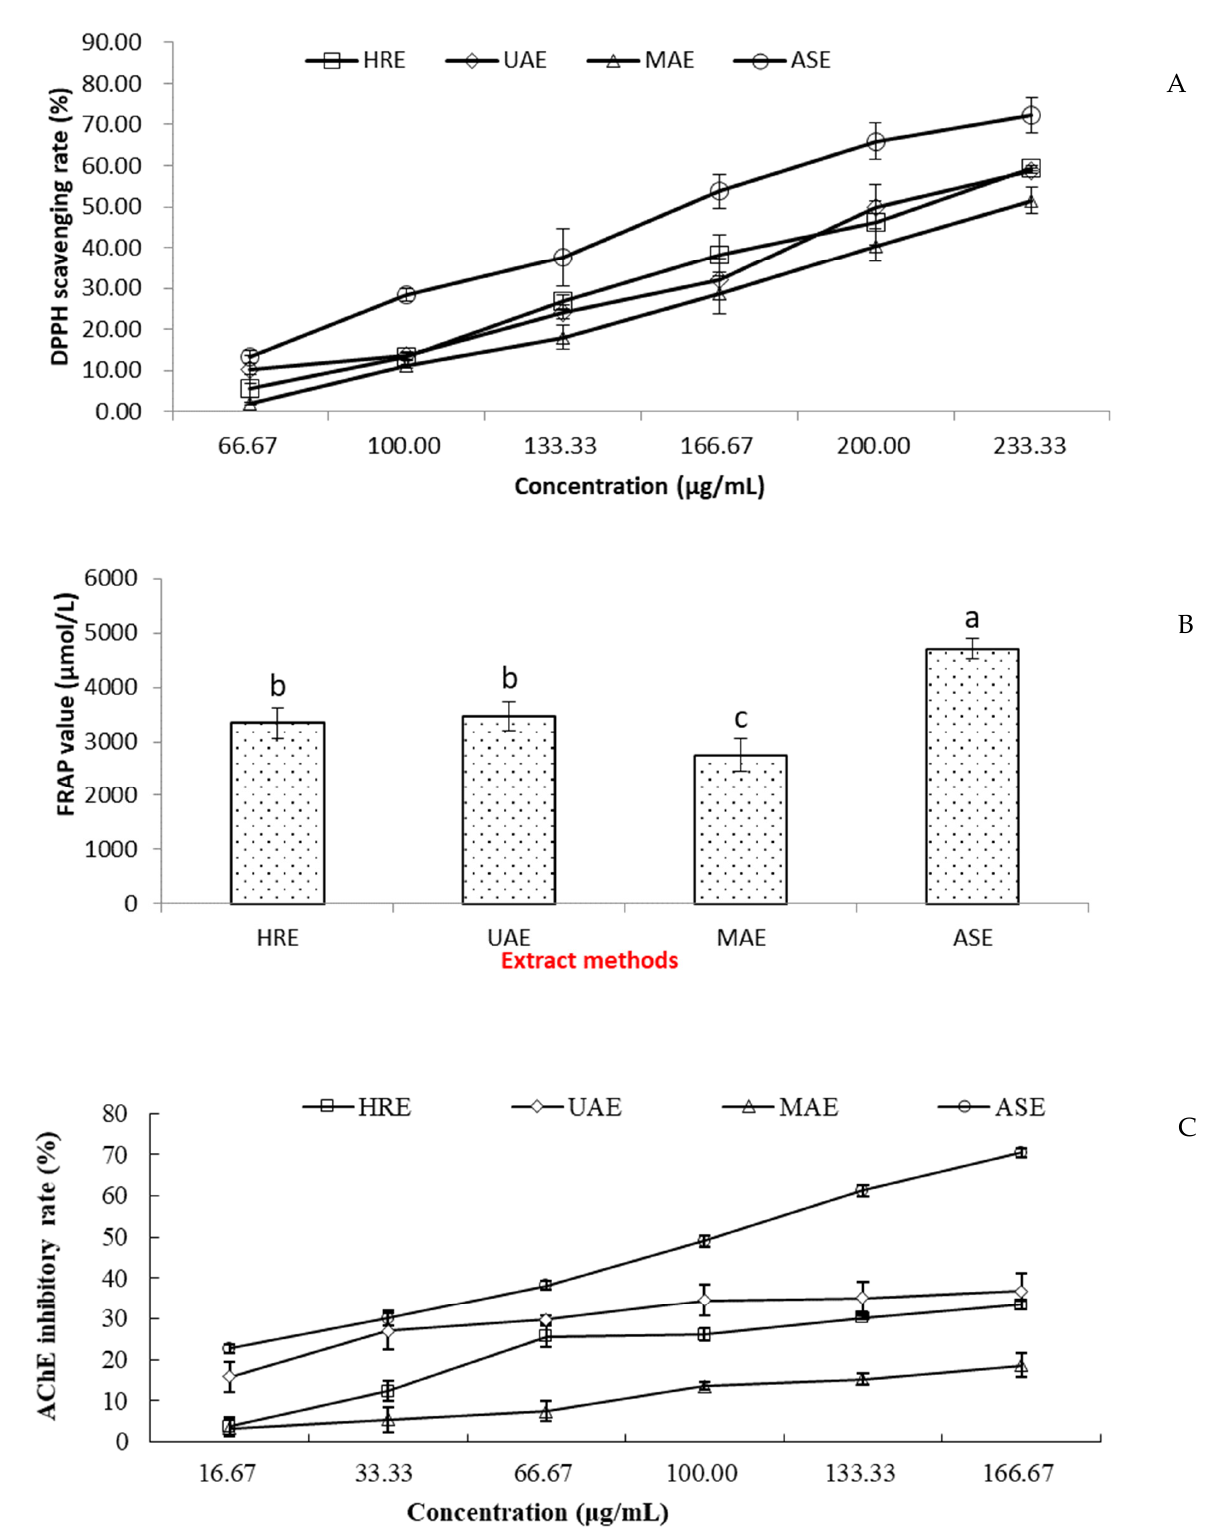
Figure 2. Antioxidant and AChE inhibitory activities of the different Gardeniae fructus extracts. ( A ) DPPH scavenging ability, ( B ) FRAP assay, and ( C ) AChE inhibitory ability. HRE: heated refluxing extraction; UAE: ultrasound-assisted extraction; MAE: microwave-assistedextraction; ASE: accelerated solvent extraction. Note: a–c, in ( B ) mean significant difference between the extract methods ( p < 0.05).